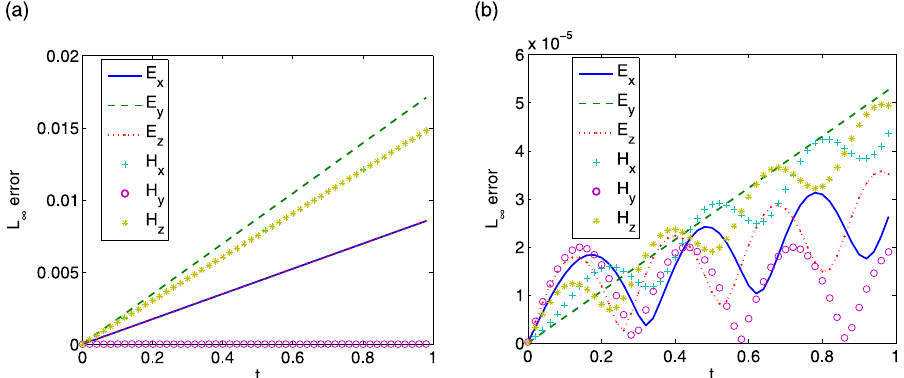
Fig 9. L 1 errors of numerical solutions to LOD central box scheme (left) and LODEFMS scheme (right) in first testing case.